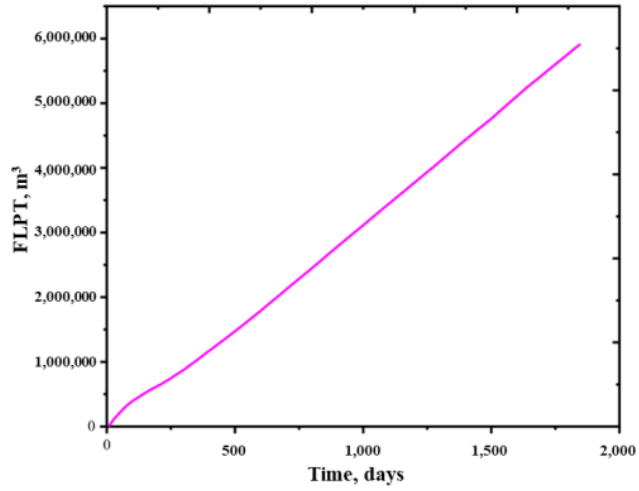
Figure 23. Field liquid production total for vertical wells.